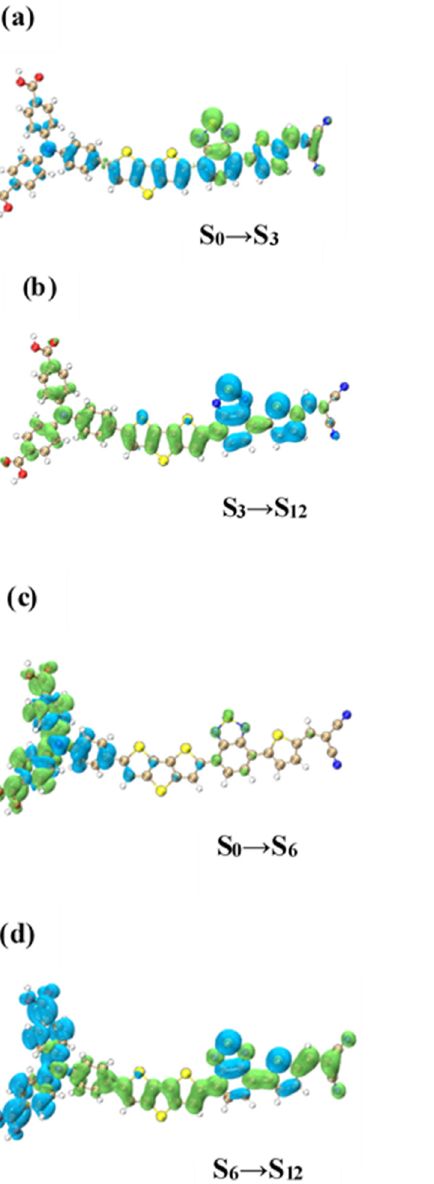
Figure 11. TDM and CDD of WS7 in TPA. TDM and CDD of S 0 → S 3 ( a ) of WS7, TDM and CDD of S 3 → S 12 ( b ) of WS7, TDM and CDD of S 0 → S 6 ( c ) of WS7, TDM and CDD of S 6 → S 12 ( d ) of WS7.